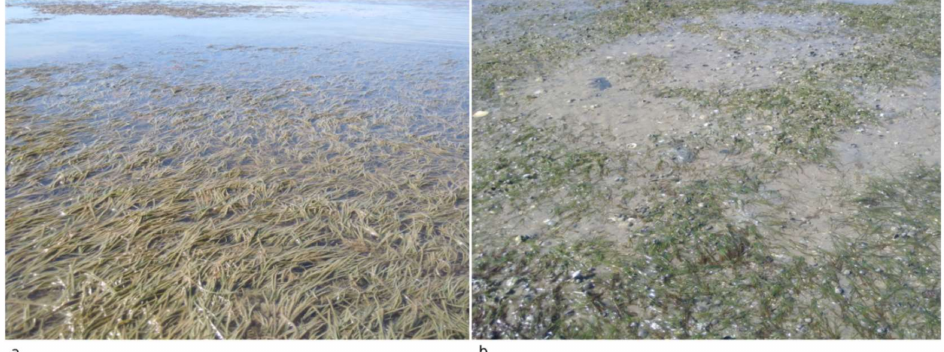
Figure 2. Dense ( a ) and sparse ( b ) seagrass meadows in Tauranga Harbor (photographs taken by Nam Thang